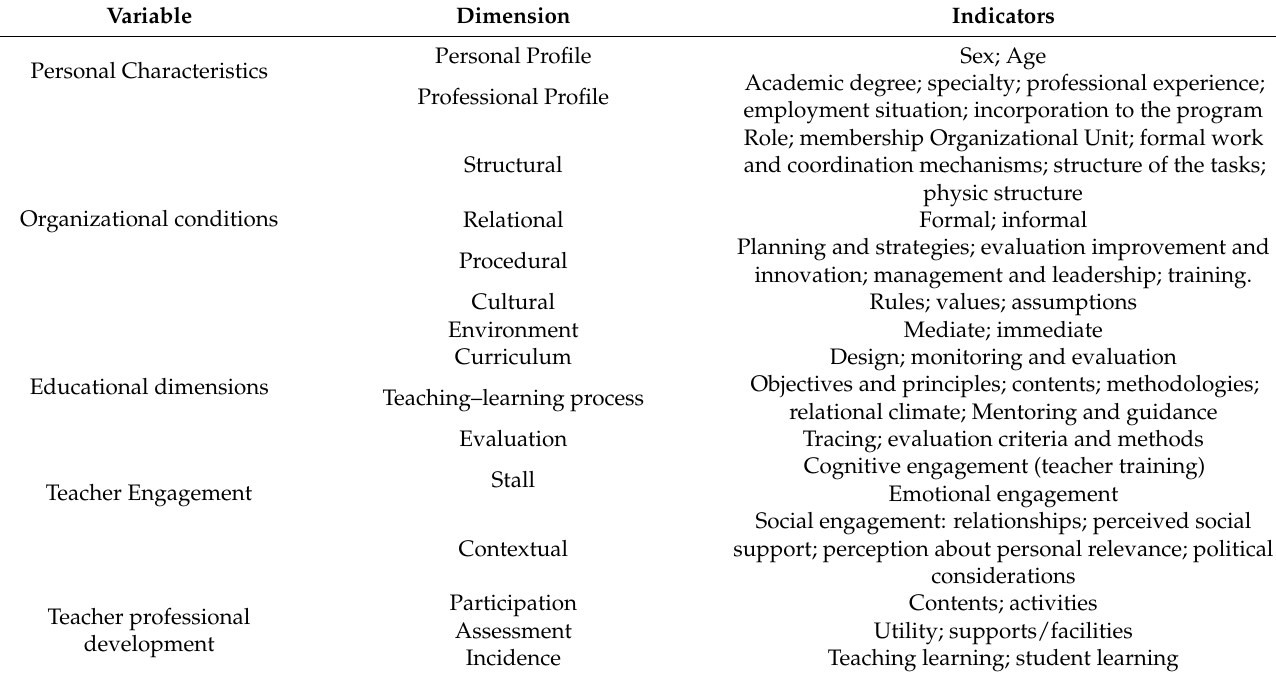
Table 2. Operationalization of variables of the questionnaire aimed at participating